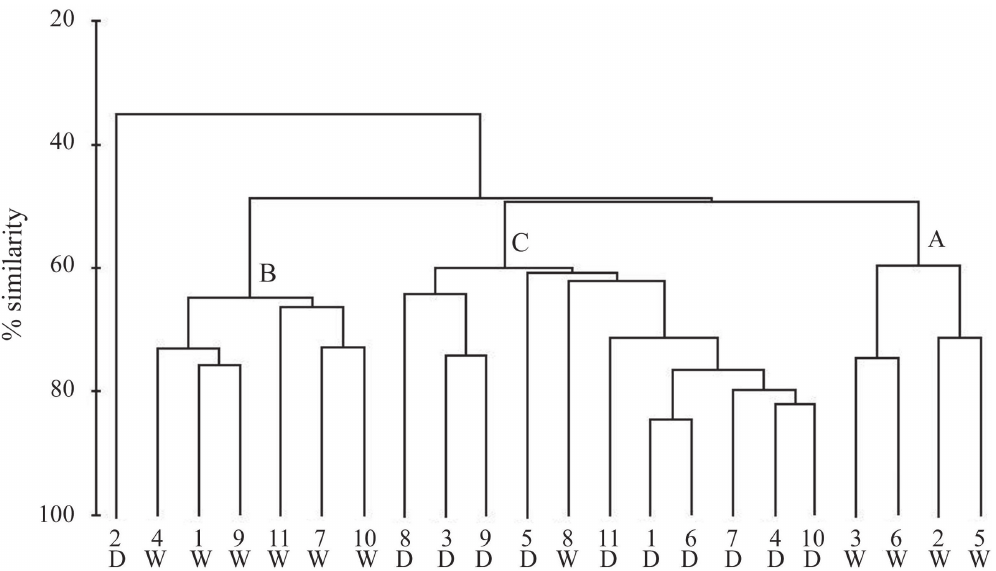
Figure 12. Cluster analysis performed for samples-species data matrixes of the two seasons in sampling stations on the inner shelf adjacent to Camamu